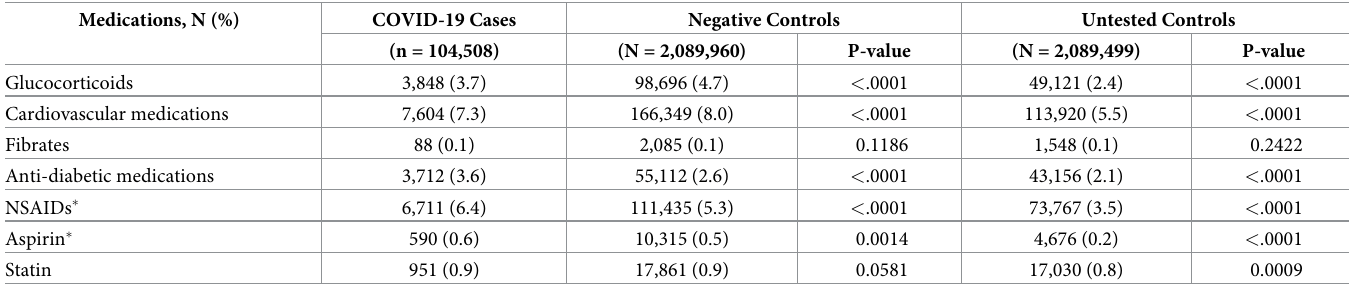
Table 3. Medication used in the year prior to index date for COVID-19 cases, negative controls, and untested controls. Medications, N (%)